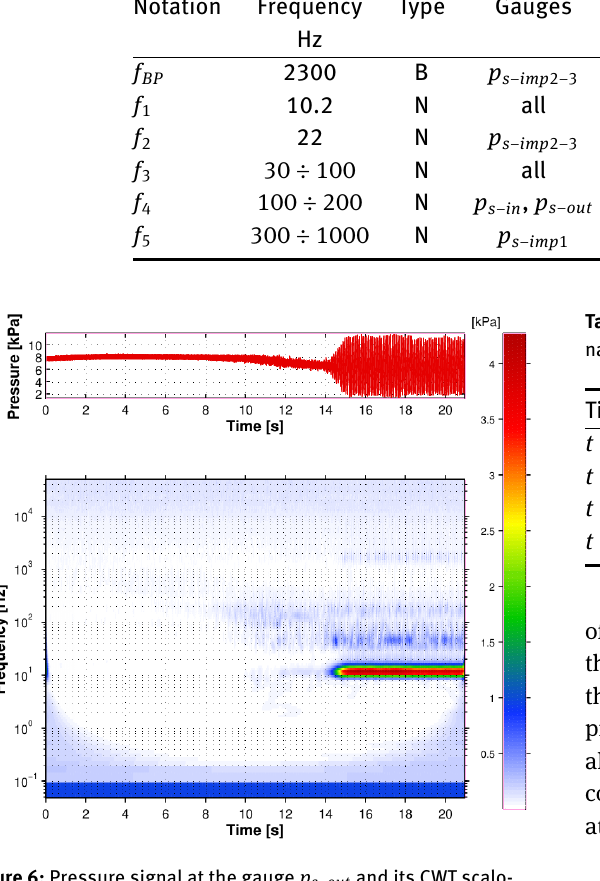
Figure 6: Pressure signal at the gauge p s − out and its CWT scalo- gram.